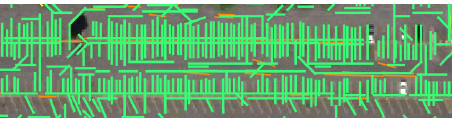
Figure 9. Parking lot with small lines also detected with the bulk of the parking edges detected